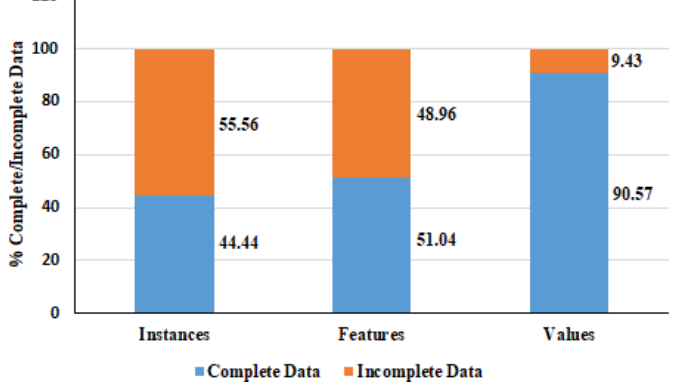
Fig. 2. Percentages of complete/incomplete data in instances, features, and values of Pima Indians Diabetes